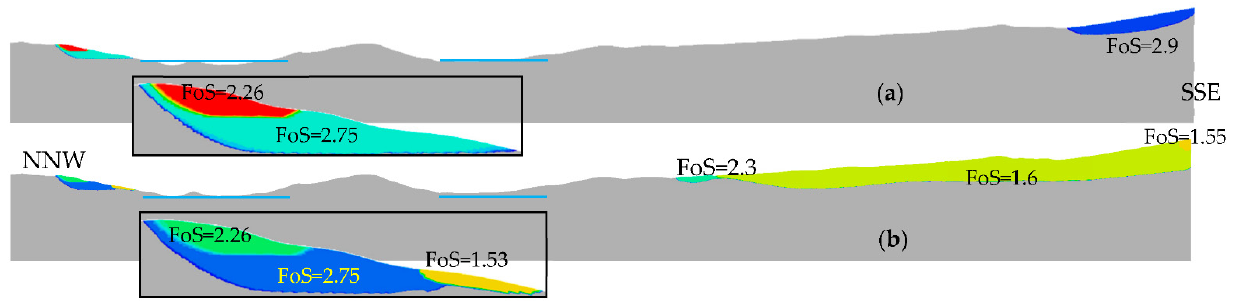
Figure 3. FoS contours for the 4629 m length NNW-SSE cross section with distributions of C, E, ϕ and ρ in the dump units ( a ) without contact layer. ( b ) with contact